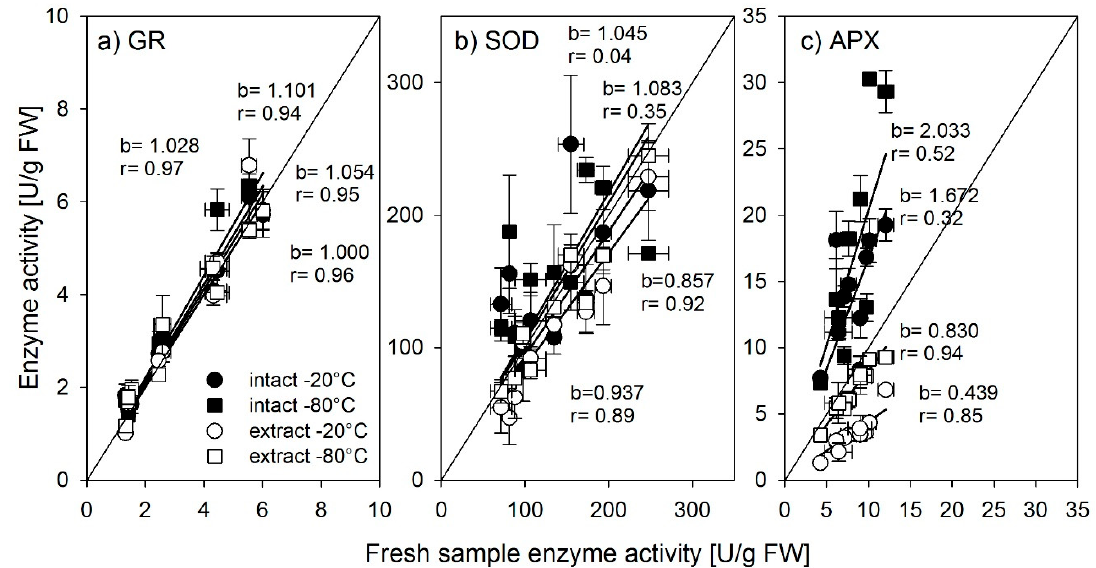
Figure 3. Activity of ( a ) glutathione reductase, ( b ) superoxide dismutase, and ( c ) ascorbate peroxidase determined in fresh samples compared to samples stored as tissue material cut in small pieces. Open symbols: samples stored as extract; filled symbols: intact stored at − 20 °C (circles) and − 80 °C (squares) and measured 12 weeks after harvest; b depicts the slope of the regression line, r = the correlation coefficient r 2 . Error bars = standard error of mean (n = 3).